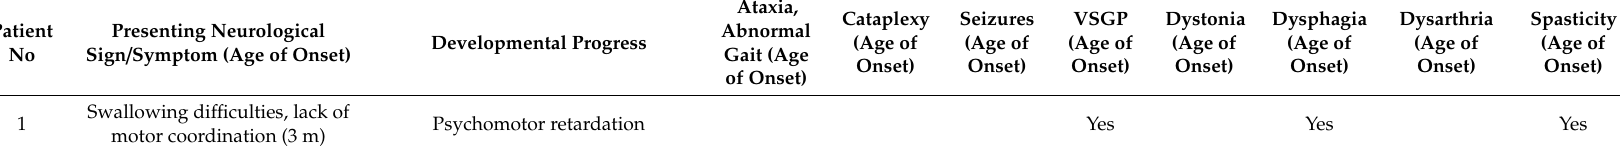
Table 3. Range of neurological symptoms and signs. Patients selected from the total group on the basis of presence of more than one neurological symptom or sign. Patient number is linked to Table